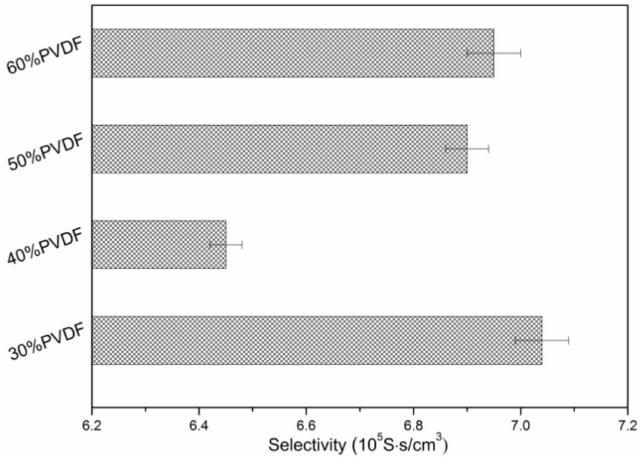
Figure 6. Selectivity of the s -PI-PVDF composite